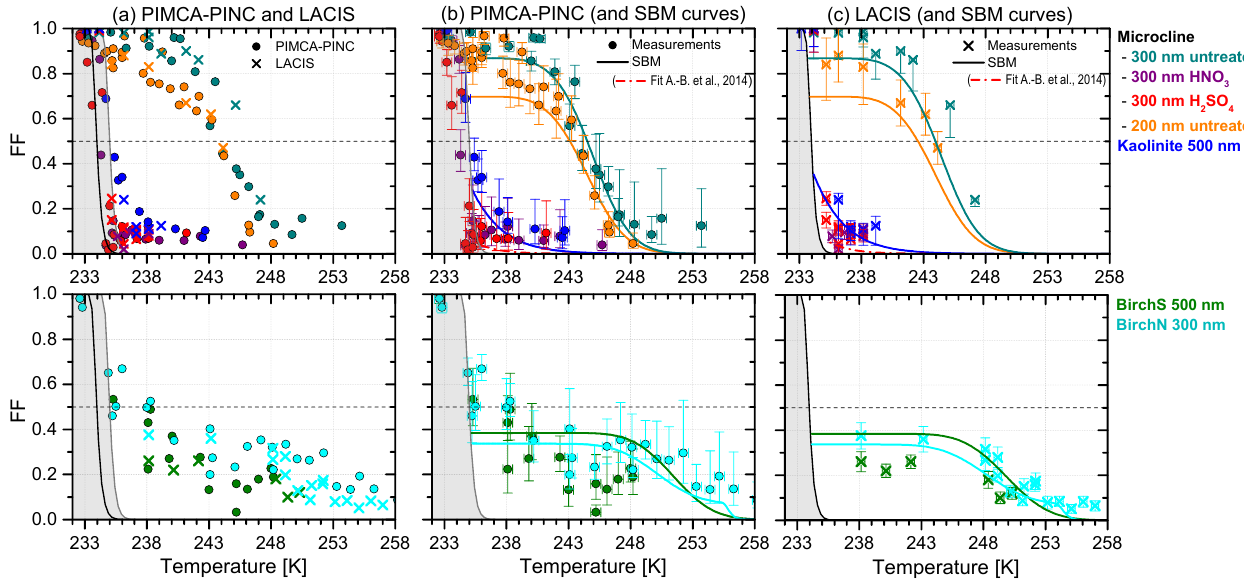
Figure 2. Summary of immersion-mode experiments. (a) Results are shown for untreated and either nitric- or sulfuric-acid-treated mineral dusts (upper panel) and for birch pollen washing waters of two sources (birchS and birchN, lower panel) for PIMCA-PINC and LACIS. The grey and black curves represent homogeneous freezing for PIMCA-PINC (Kohn et al., 2016) and LACIS, respectively, which differ due to differences in droplet size and residence time. T 50 at which half of the droplets have frozen is indicated by the horizontal dashed black line. Columns (b) and (c) : curves (except red) show results of the SBM using fit parameters from literature (see text for details) for comparison to data obtained with PIMCA-PINC (b) and LACIS (c) in this study. The red curve is taken from Augustin-Bauditz et al. (2014) representing a fit line to measurements of acid-coated mineral dust. Error bars show the uncertainty in ice detection and the uncertainty in T in each